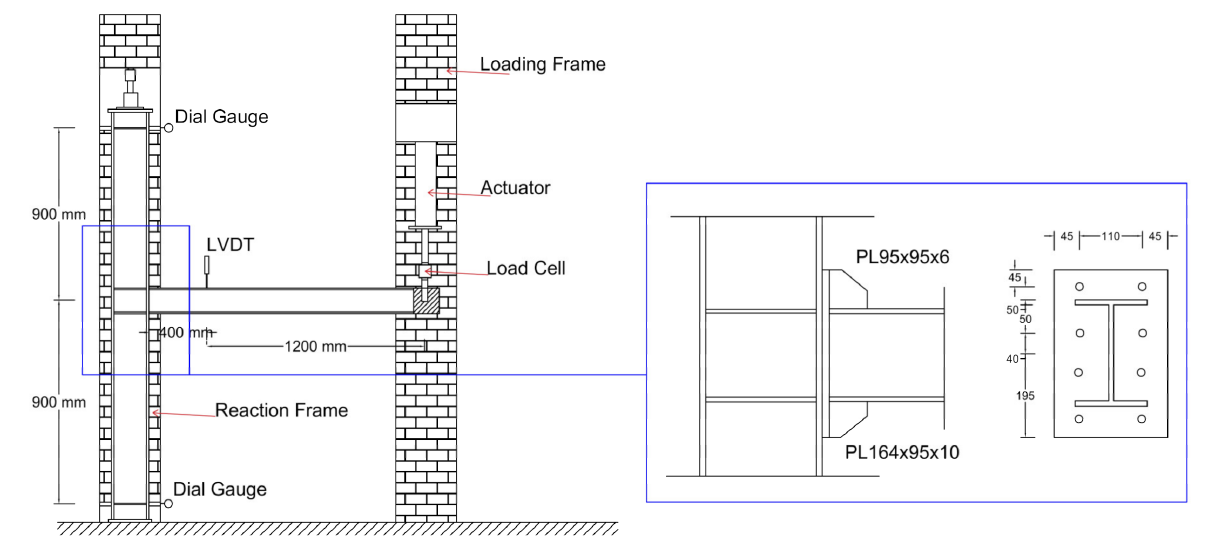
Figure 2. Geometrical details of the specimen [28] (units are given in mm, LVDT: linear variable differential transformer, PL: